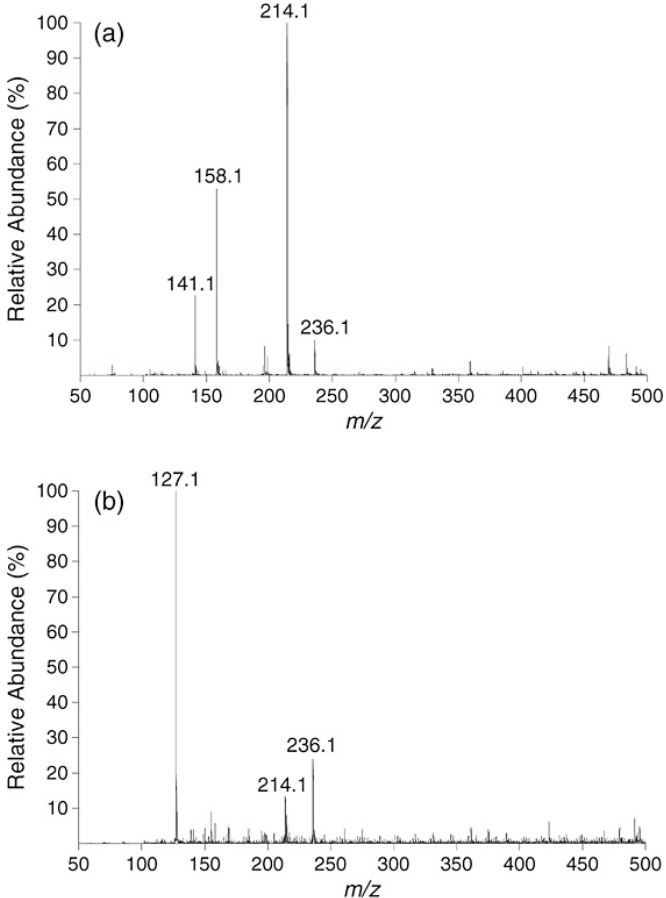
Figure5. Positive-ionLESA-MSspectraobtainedonpigmentedpolyester-basedcoilcoatingsformulated without HALS. ( a ) before outdoor exposure; ( b ) after 4 years of outdoor exposure. (Reprinted from [35] with permission of John Wiley and